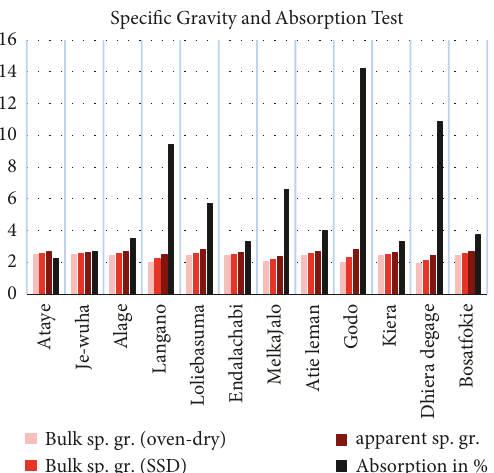
Figure 9: Specific gravity and water absorption (source: test results for this study).